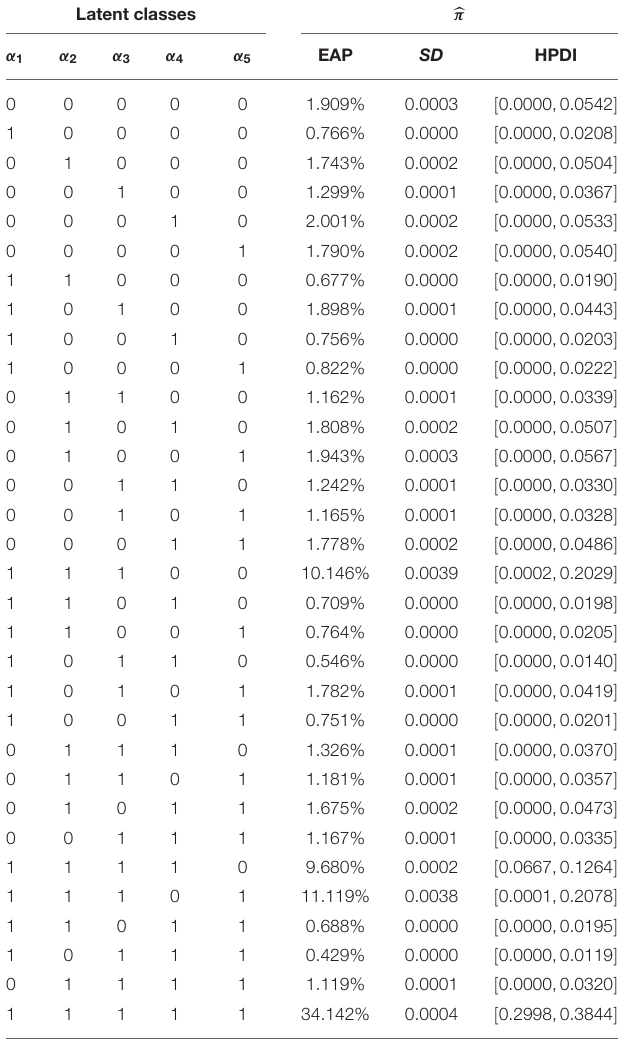
TABLE 7 | The posterior probability distribution of the latent class parameters for the Fraction Subtraction Test. Latent